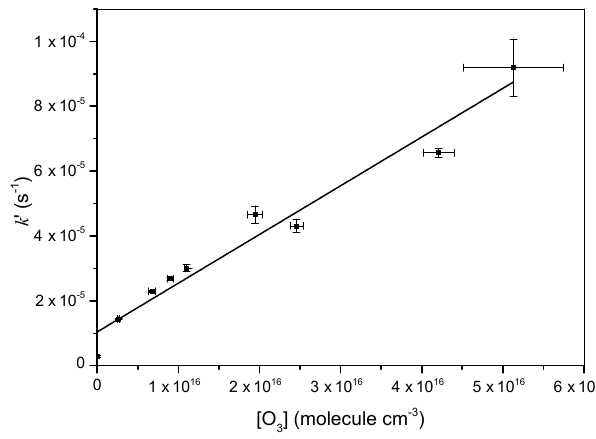
Figure 10. Pseudo-first-order decay constant of C 3 O 2 plotted against the O 3 concentration. The slope is the bimolecular rate con- stant k 6 . The horizontal errors bars represent uncertainty in the O 3 concentration based on analysis of three different spectral regions (see text). The vertical error bars are 2 σ from the fits to data as shown in Fig.